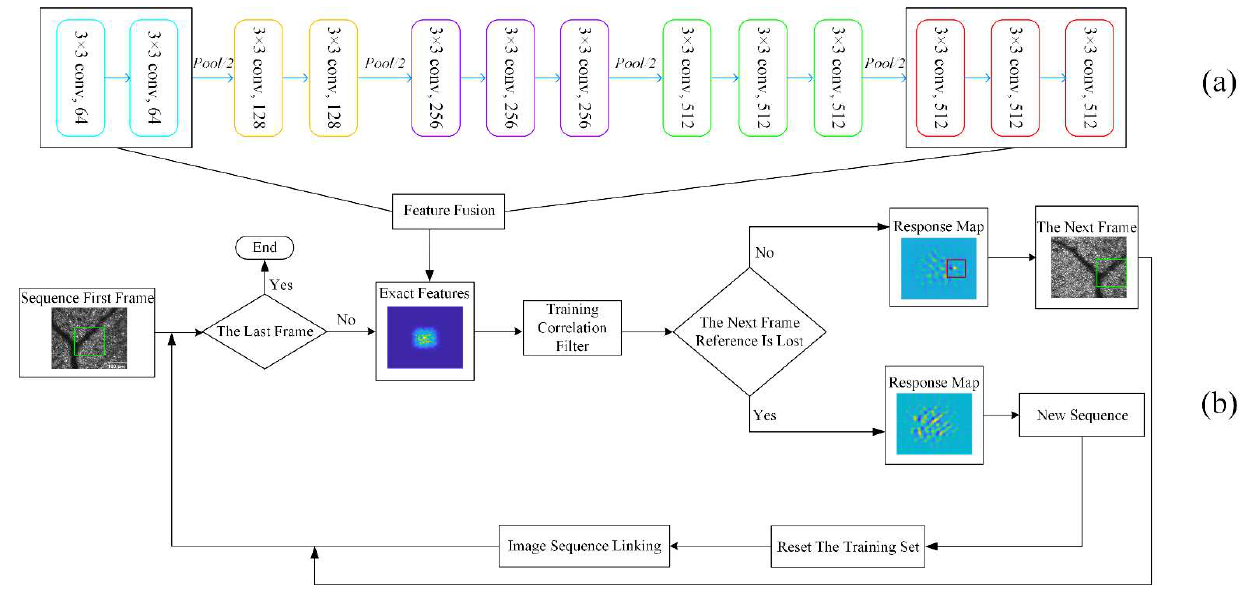
Figure 3. VGG-16 network structure diagram and UECO core step diagram; ( a ) is the 5 convolution groups of VGG-16, and the convolution groups are connected by a pooling layer. ( b ) is the UECO core diagram. The kernel size of the convolution layer in the convolution group was 3 × 3, and the number of channels in each convolution group was 64, 128, 256, and 512, respectively. The window size of the pooling layer was 2 × 2, reducing the feature map to 1/2 of its original size. The features of the first convolution group (conv3-64) and the features of the fifth convolution group (conv3-512) were fused by a cascade to train the correlation filter. The scale bar is 100 µ m. The green and red boxes in ( b ) are the UECO